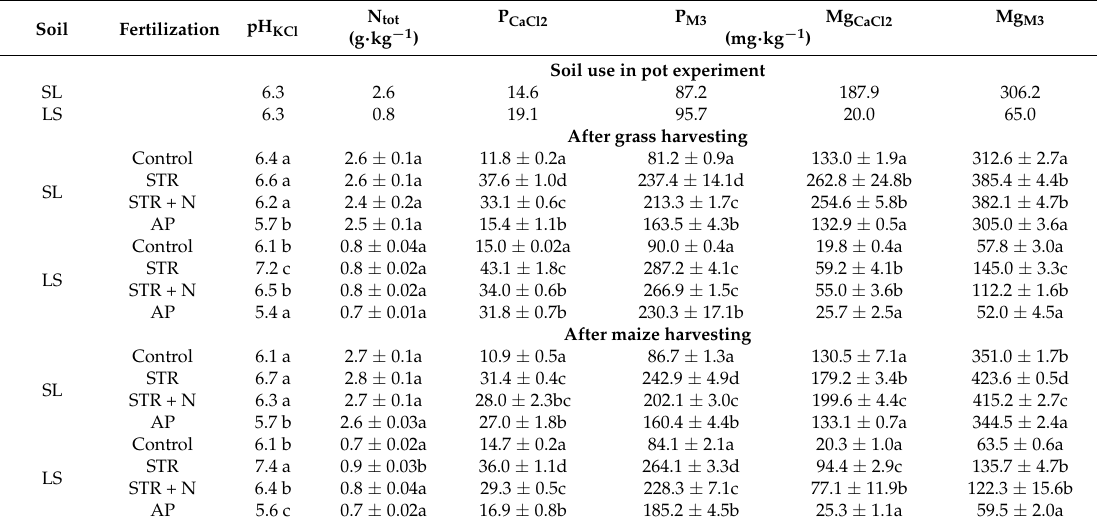
Table 2. Soil pH KCl and nutrient concentration in